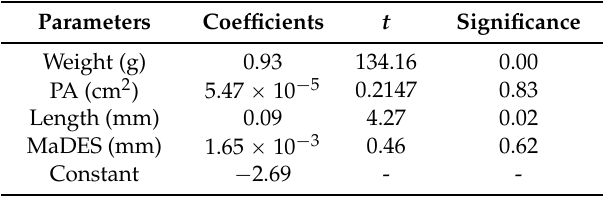
Table 4. Statistical results of the multiple linear regression (MLR) model for determining volume of the kiwifruits.